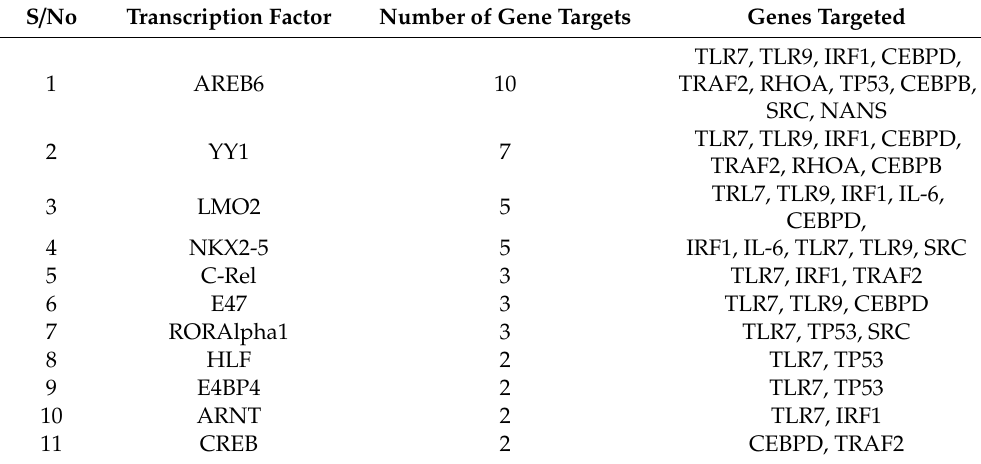
Table 3. List of predicted transcription factors targeting 11 genes significantly expressed during infection with bovine coronavirus.